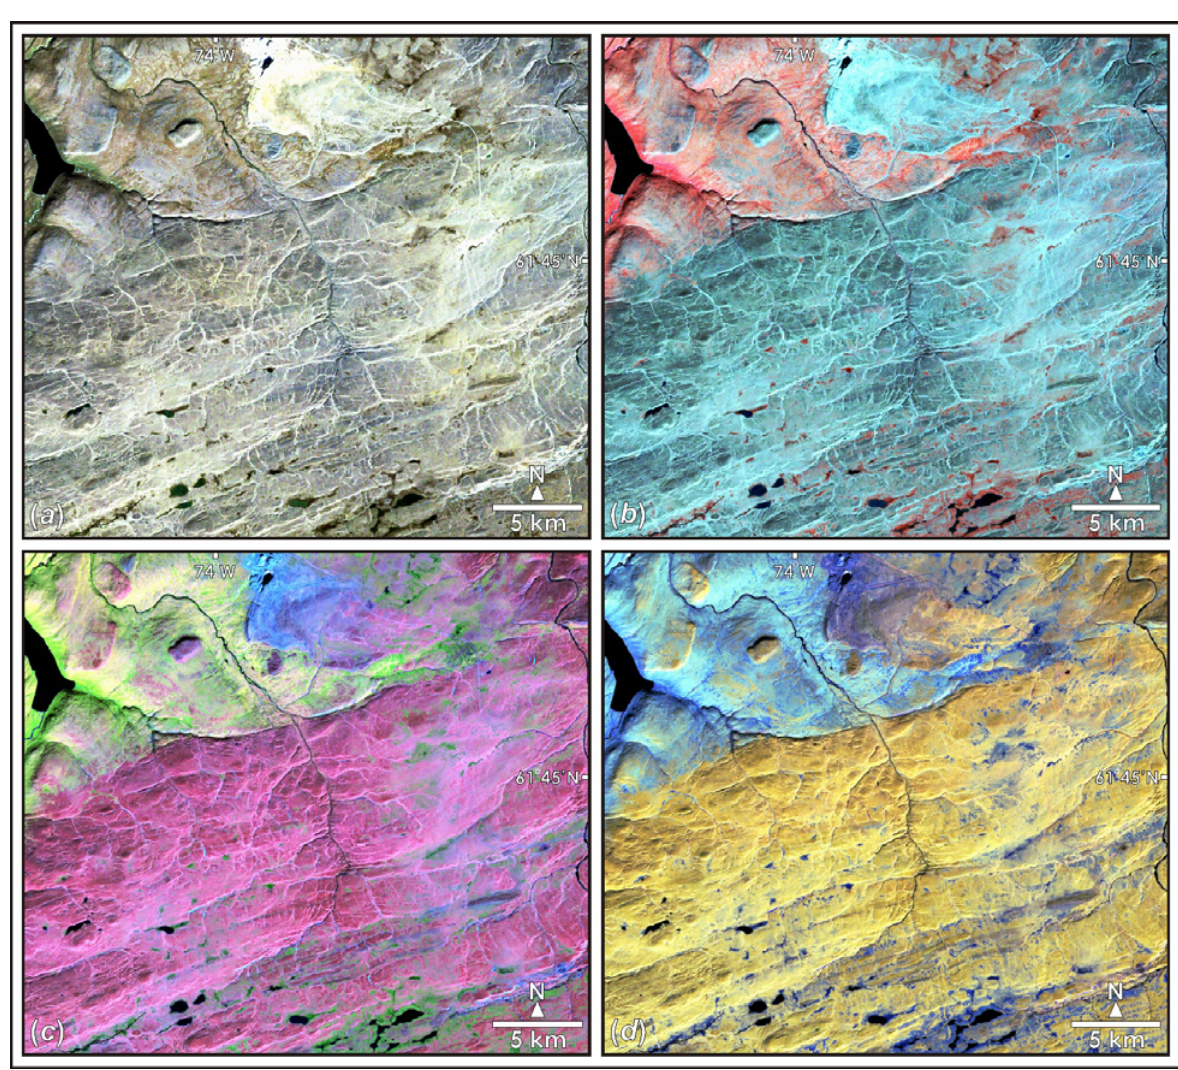
Figure 3. Landsat TM color composites of the study area depicted in Figure 2. ( a ) 321-RGB (true color). ( b ) 432-RGB (color infrared). ( c ) 543-RGB. ( d )